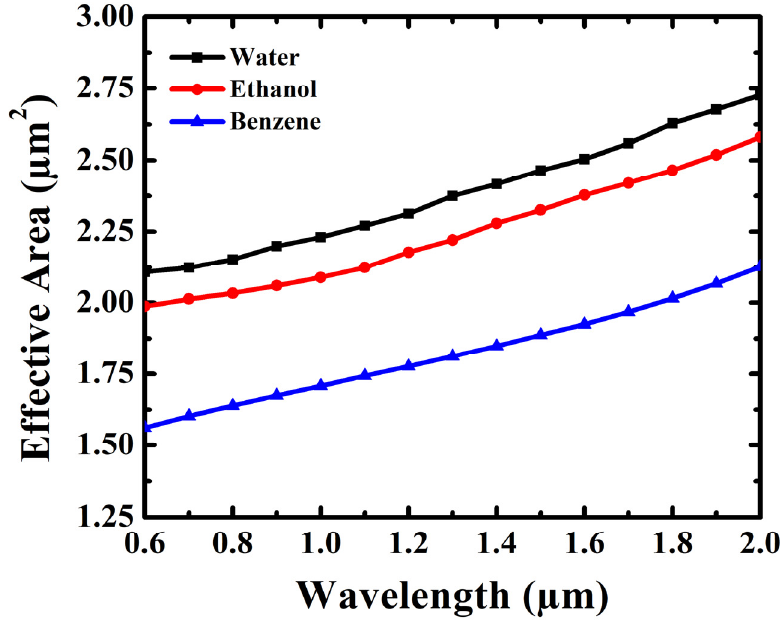
Figure 9. Effective area of the PCF sensor with water, ethanol and benzene, for different operating wavelengths.